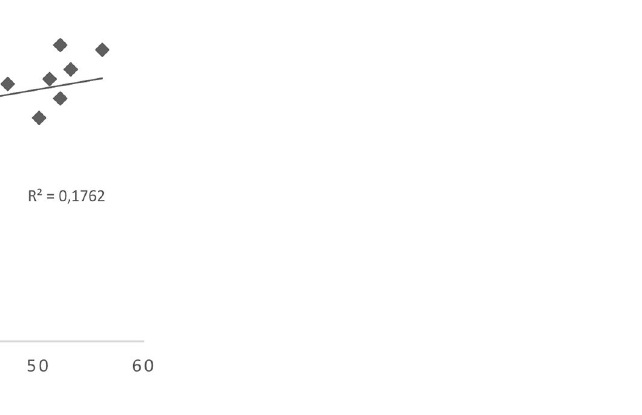
Figure 3. Scatterplot showing the relationship between self-reflection scores and scores on the positive-constructive day- dreaming category, N =